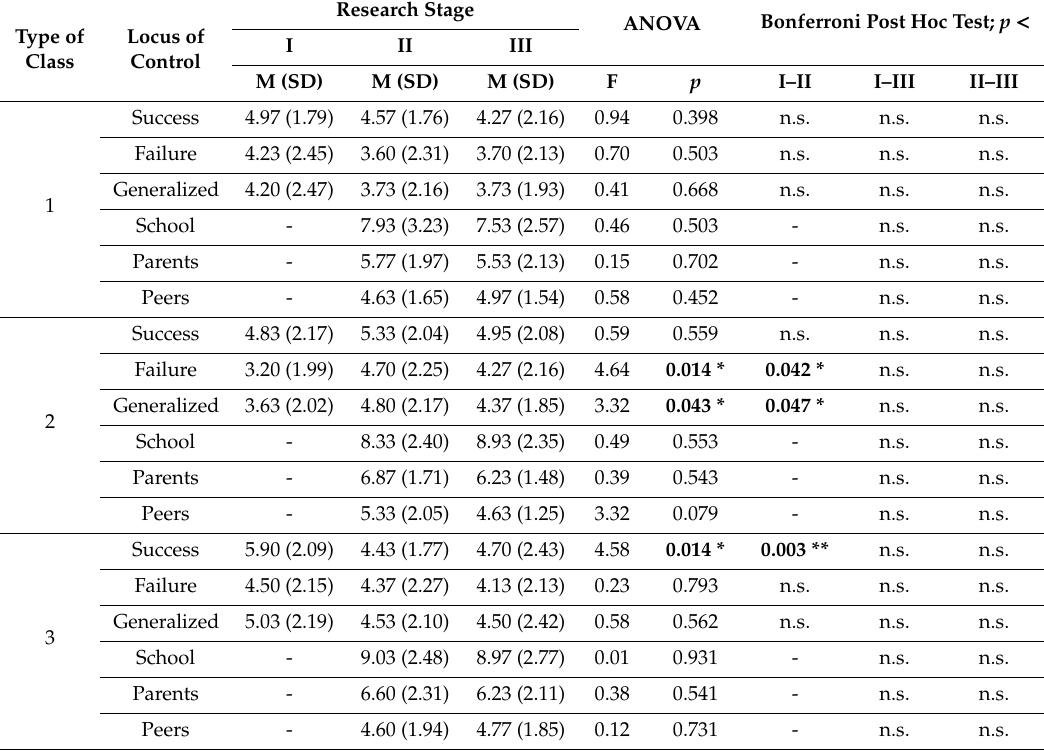
Table 2. Repeated-measures ANOVA of locus of control scores obtained by students from integrated and non-integrated classes in the school years 2016 / 2017 (research stage I), 2017 / 2018 (research stage II), and 2018 / 2019 (research stage